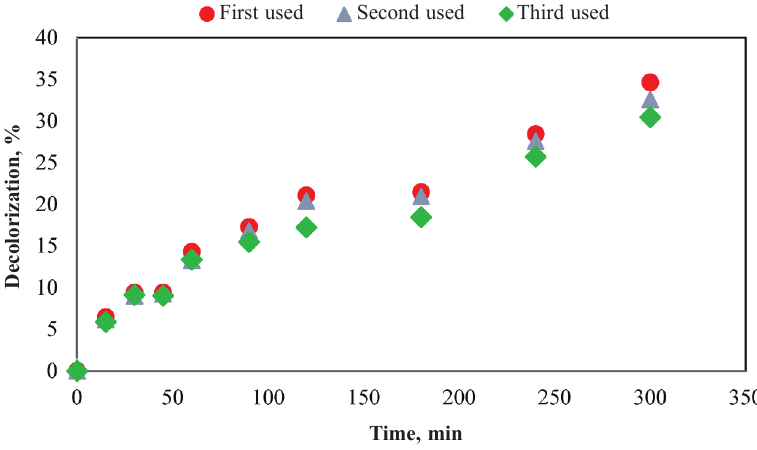
Fig. 8 – Stability of TiO